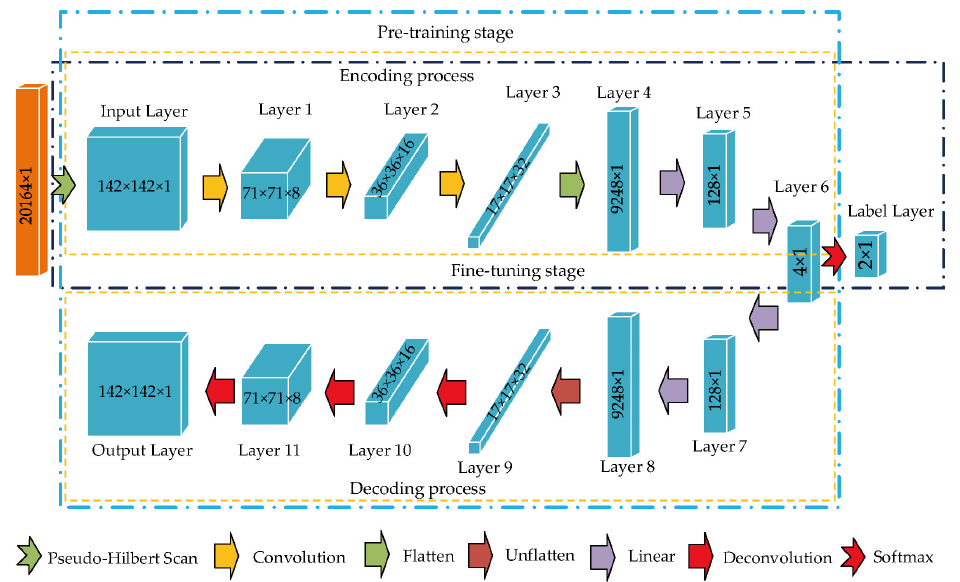
Figure 6. The proposed two-stage training CAE network architecture.